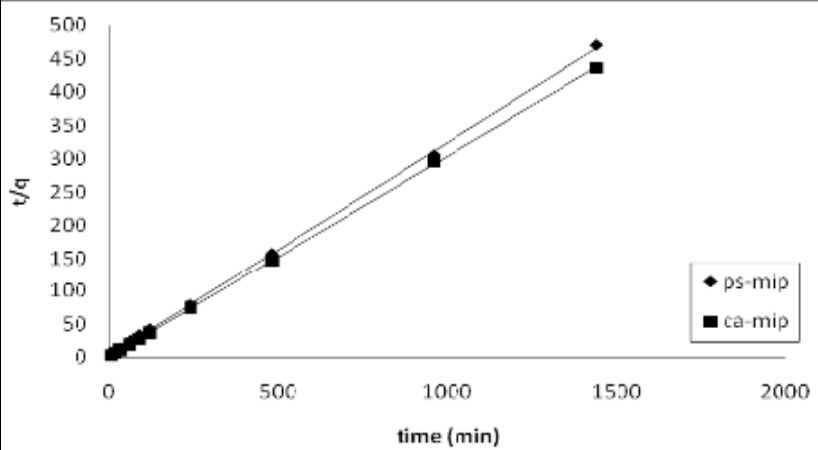
Figure 7. Second-order kinetic plots for the sorption of 2,4-DNP by CA-MIP and